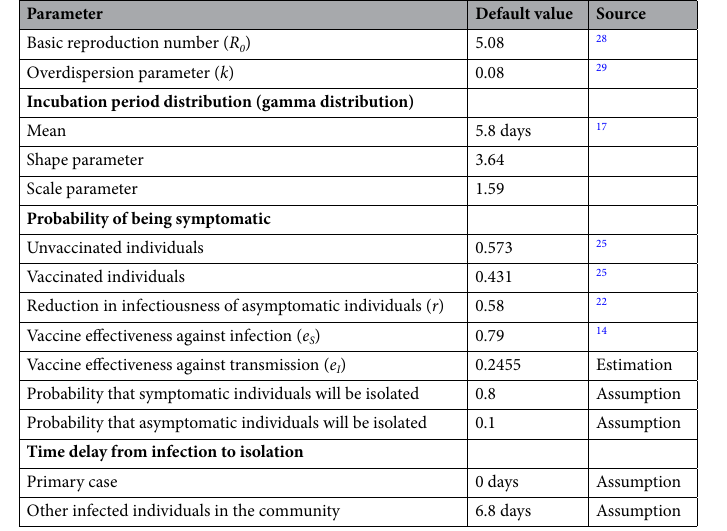
Table 1. Model parameters and their default